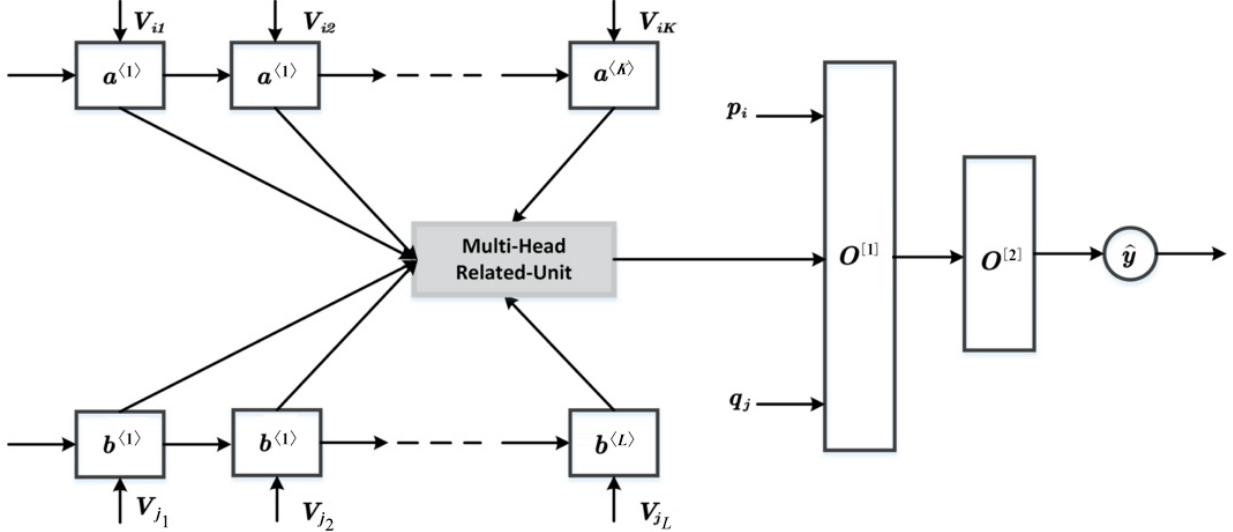
Fig. 2 Architecture of the